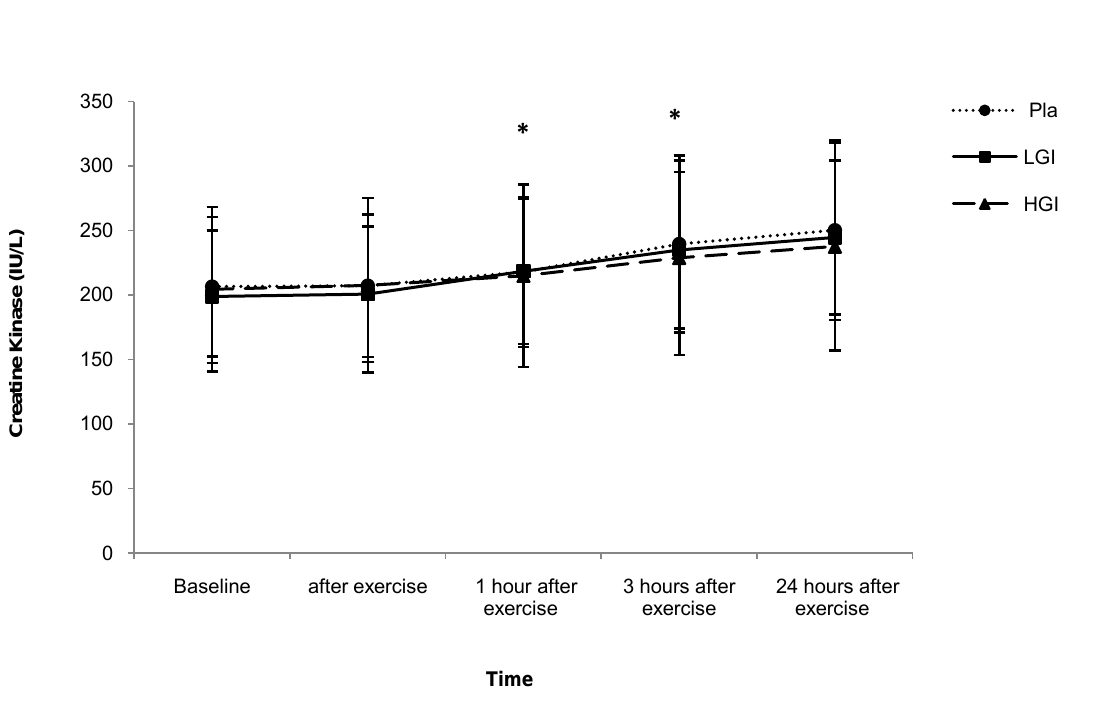
Fig.2. Mean concentration of serum CK for Pla, LGI and HGI diet groups at the various time points. Values are mean ± SE. Pla = placebo, LGI = Low glycemic index, HGI = High glycemic index. Blood glucose: The serum concentration of glucose was measured to identify differences in the diets between conditions. At the baseline, there was no significant difference for glucose between trials. Glucose increased significantly following carbohydrate ingestion. Concentration of glucose in HGI group was more than LGI and Pla groups, glucose was elevated above baseline values at 1h after exercise in HGI and LGI groups (all P < 0.05). There was significant difference for glucose between placebo with low glycemic groups (P=0.00) and placebo with high glycemic (P = 0.00), also high glycemic with low glycemic groups (P = 0.00) in 1h after exercise. Furthermore there was significant difference for glucose between placebo with high glycemic (P=0.00) and also high glycemic with low glycemic group (P = 0.00) in 3h after exercise